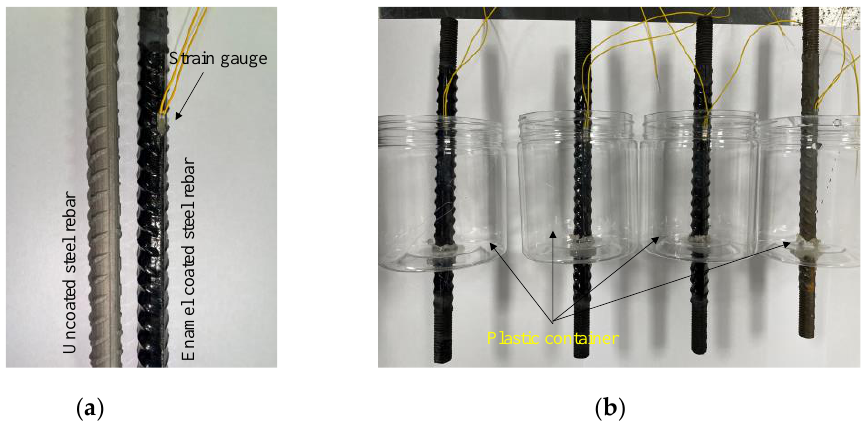
Figure 1. ( a ) Uncoated and enamel-coated steel rebar; ( b ) three enamel steel rebars and one uncoated steel rebar mounted with a plastic container.